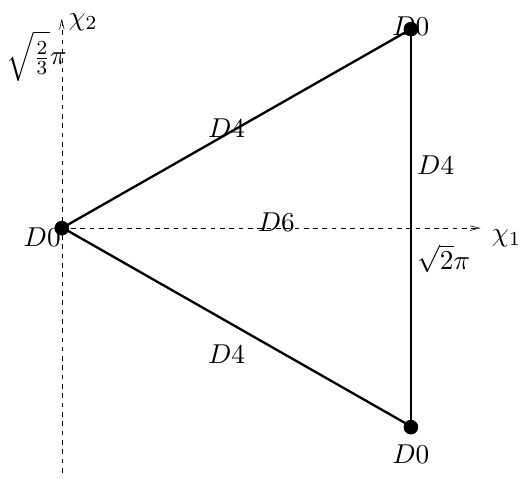
Figure 1 . Domain for position of the D